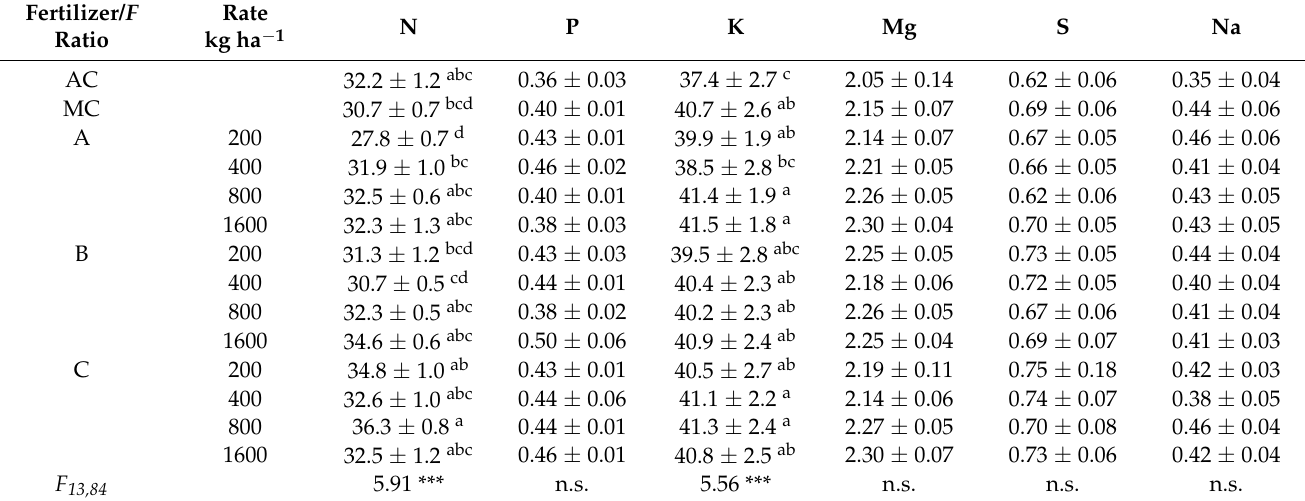
plots fertilized with the C fertilizer. For the B fertilizer, the highest average N content was obtained for the highest its rate. Regardless of the rate, the effect of the tested fertilizers on N content was as follows: A (31.1) < B (32.2) < C (34.0 g kg − 1 ). Among all studied treatments, including the MC, the highest content of N in tomato fruits was recorded for plants fertilized with the C fertilizer at the rate of 800 kg ha − 1 . The N content was significantly higher as compared to the A200, A400, B200, B400 and MC plots. Contrary to N, the K content in the tomato fruits grown on the MC was significantly higher in comparison to the AC (Table 3). Table 8. Effect of bio-fertilizer application on macronutrients content of tomato fruits in g kg − 1 DM (mean ± standard error). Fertilizer/ F Rate Ratio